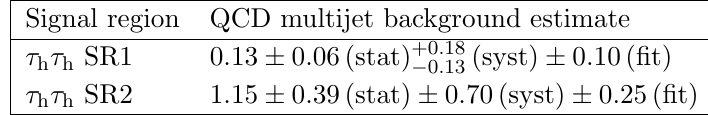
Table 2 . The estimated QCD multijet background event yields in the (cid:28) uncertainties are the statistical and systematic uncertainties of the method, and the last uncertainty is the extra systematic uncertainty due to the correlation